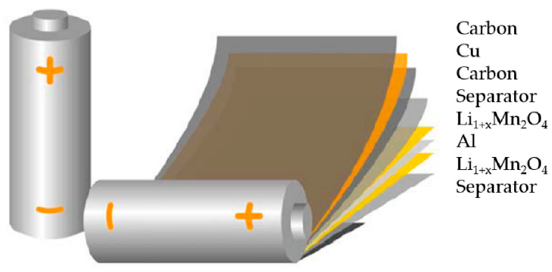
Figure 3. Schematic drawing showing the components of a lithium-ion battery [11].